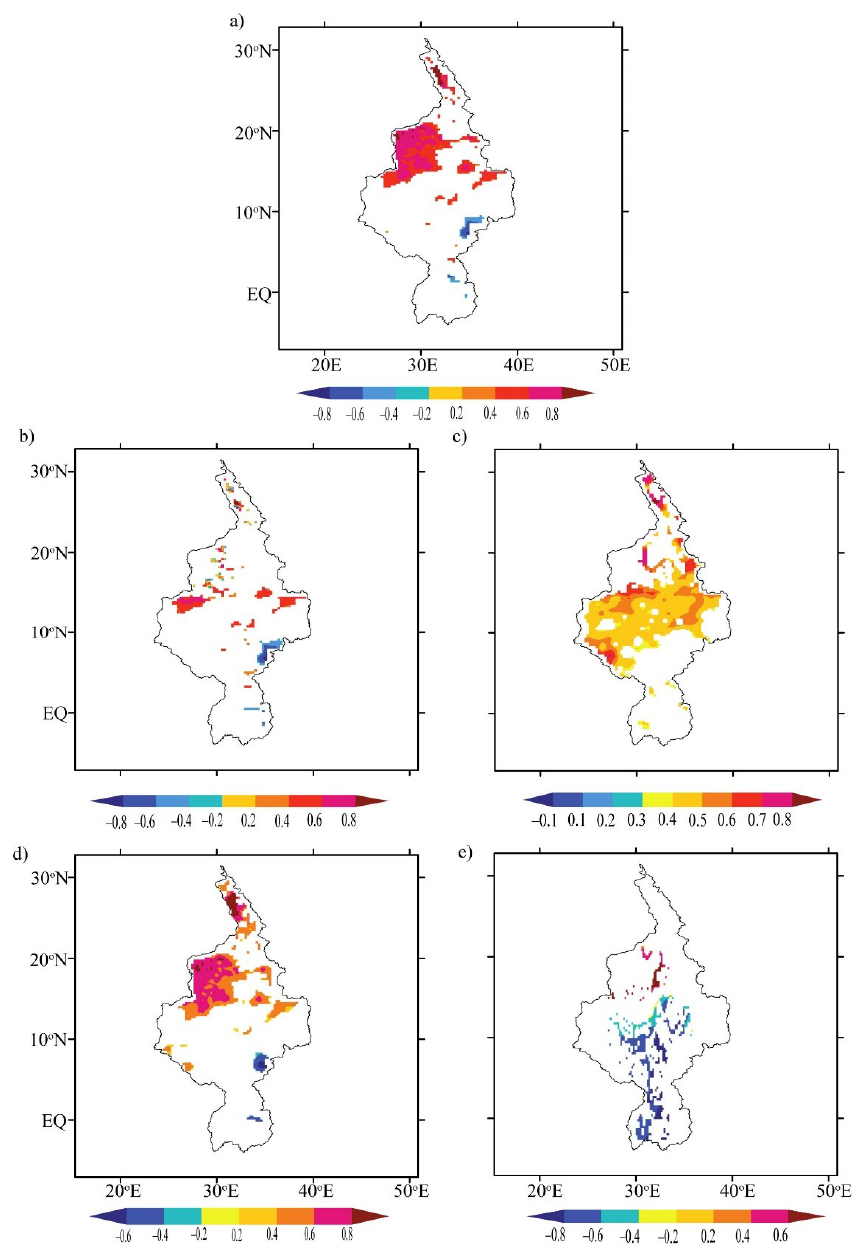
Figure 14. Pixel-wise correlation coe ffi cients between total ET and its components with P in the Nile River Basin for 1980–2014: ( a ) total ET, ( b ) transpiration, ( c ) canopy interception, ( d ) bare-soil evaporation, and ( e ) open-water evaporation. The shaded areas denote areas where the tests were significant at the 5% level.